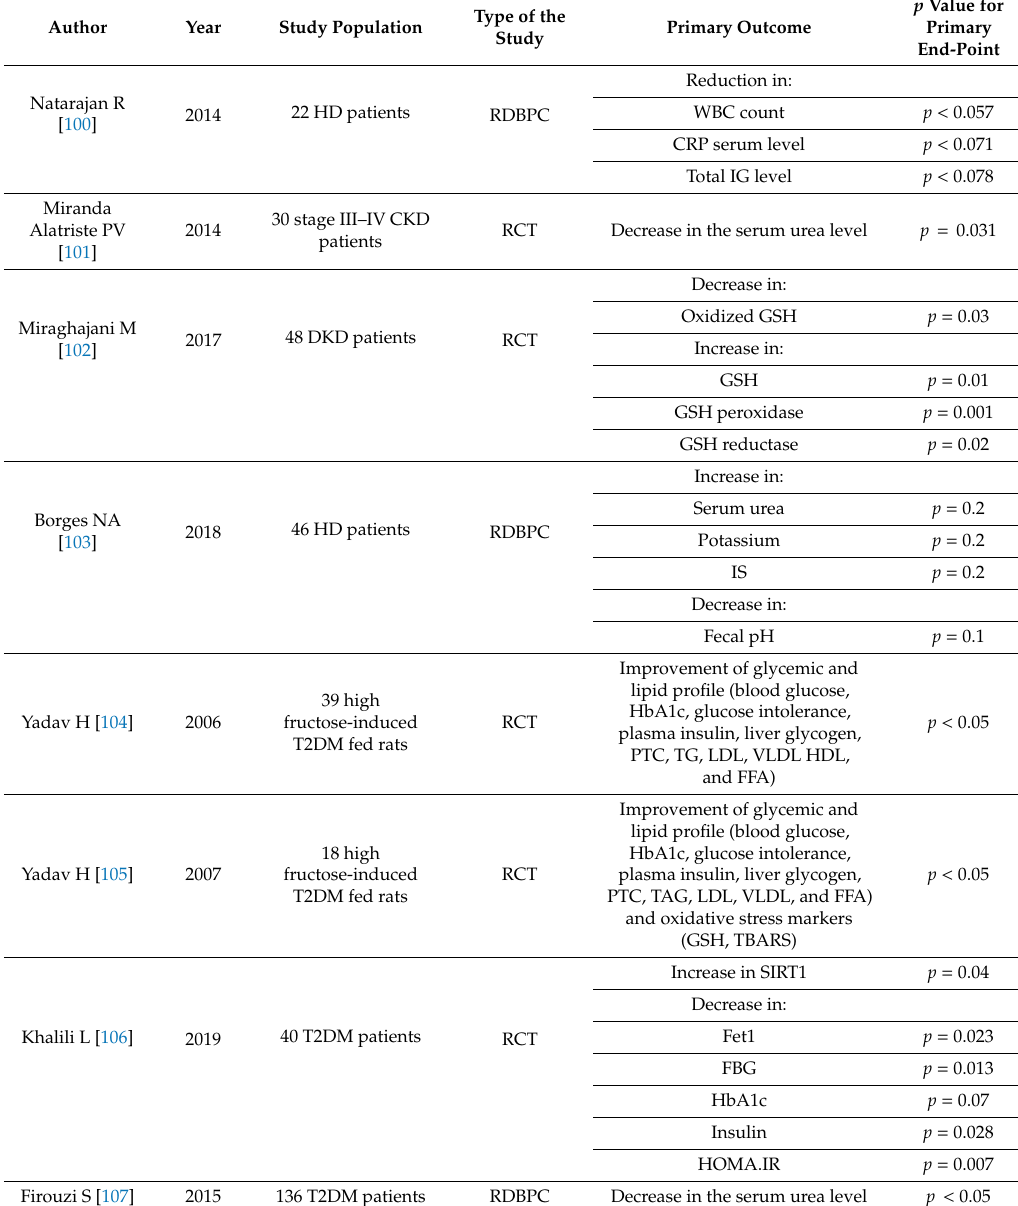
Table 1. Probiotics e ff ects on CKD, DM and